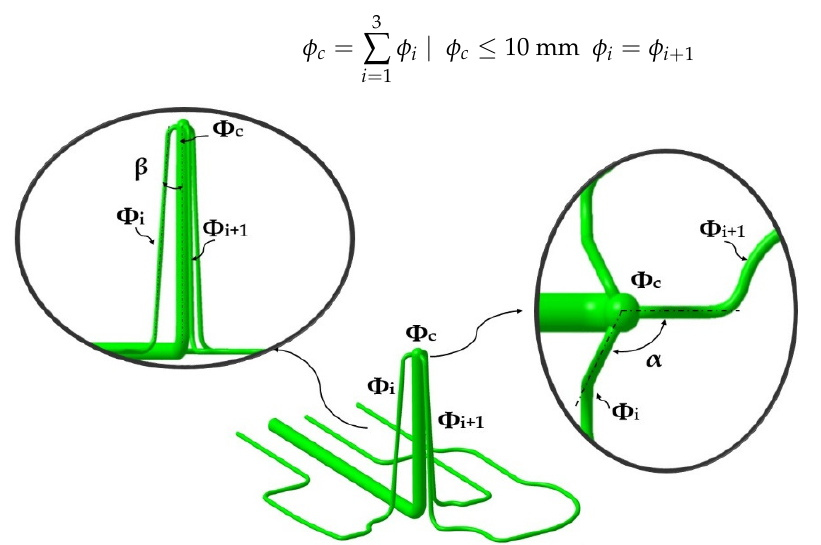
Figure 5. Conformal cooling triple hook-shaped channel.